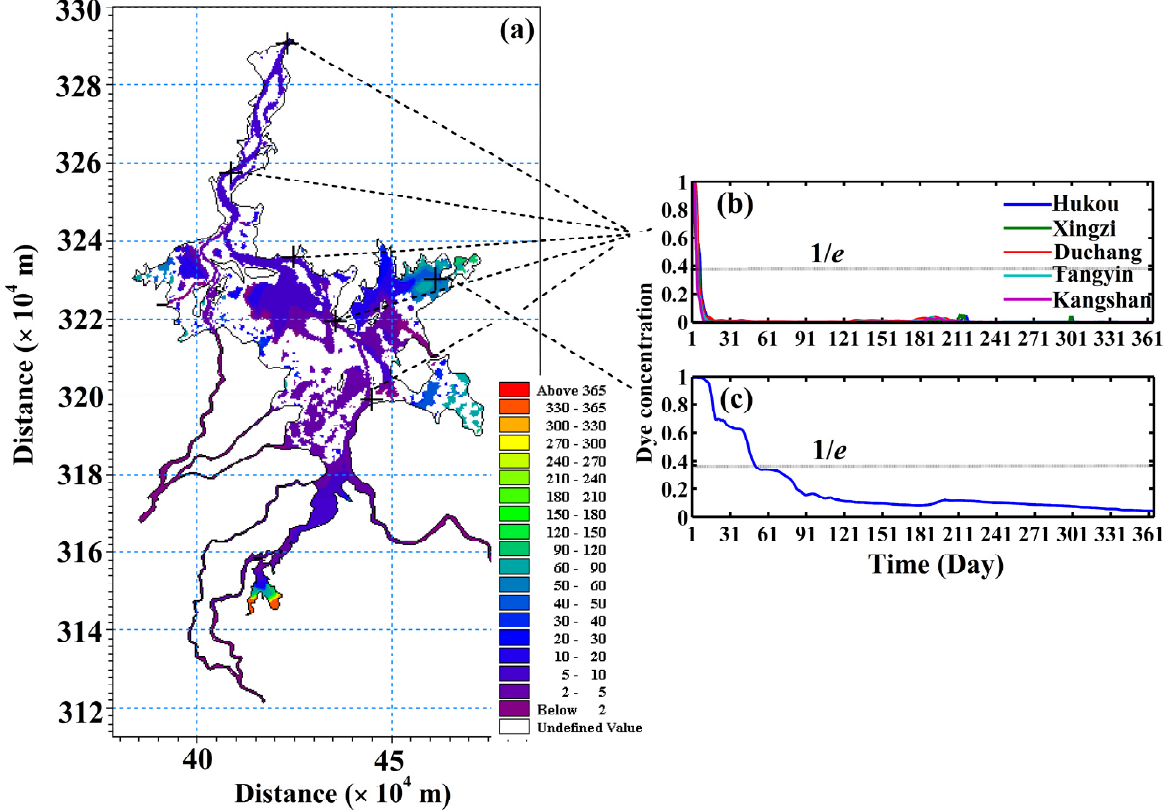
Figure 5. ( a ) Spatial distribution of the depth-averaged residence times (in days) for the water level rising period; ( b , c ) the computed dye concentrations (in kg/m 3 ) with time for the areas of interest. Releases were performed on the 1st of April during the spring. Note that the “Undefined Value” represents dry